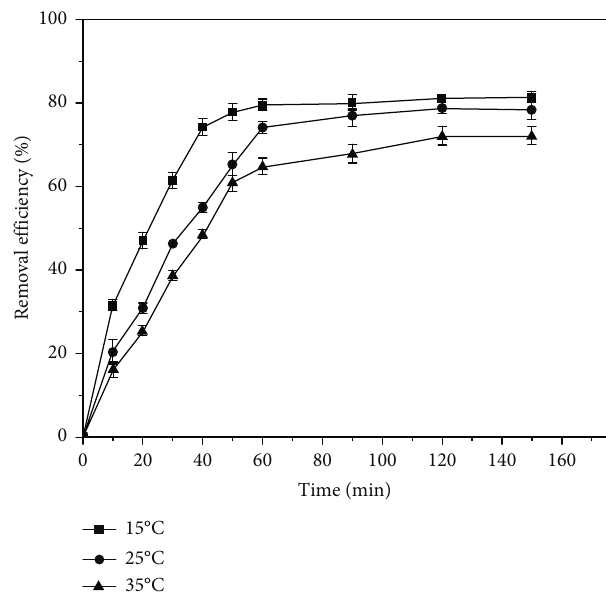
Figure 7: E ff ect of initial temperature on NO -N concentration = 30 mg/L, adsorbent = 1 : 5 g/L, pH (initial NO 3 = 7 , and contacttime = 150 min).